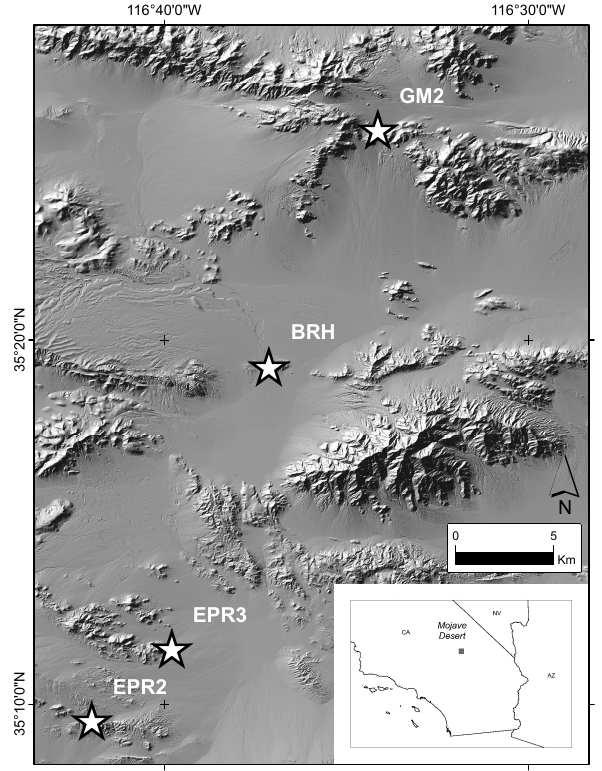
Figure 1. Location map of the four study sites (stars) in the south- ern part of Ft. Irwin, the Mojave Desert, southern CA. Topography from the lidar data is presented as shaded relief